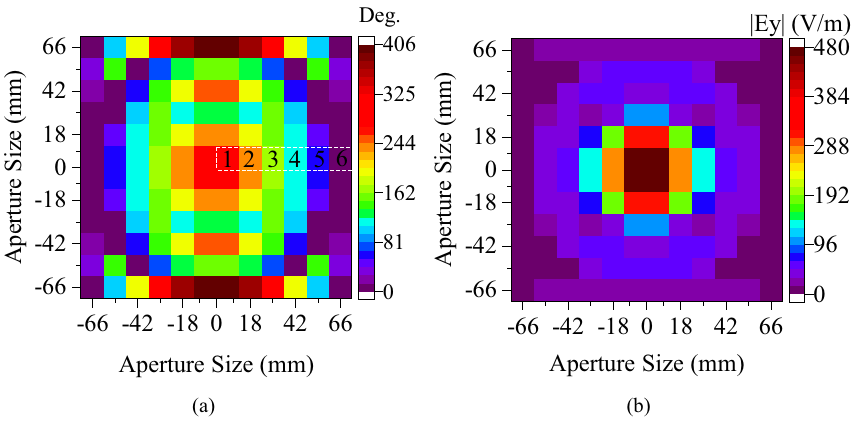
Figure 4. ( a ) The phase and ( b ) magnitude of the dominant electric field component ( E y ) on the aperture of the RCA.